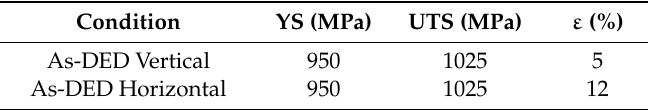
Table 6. Tensile properties of as-DED Ti-6Al-4V samples